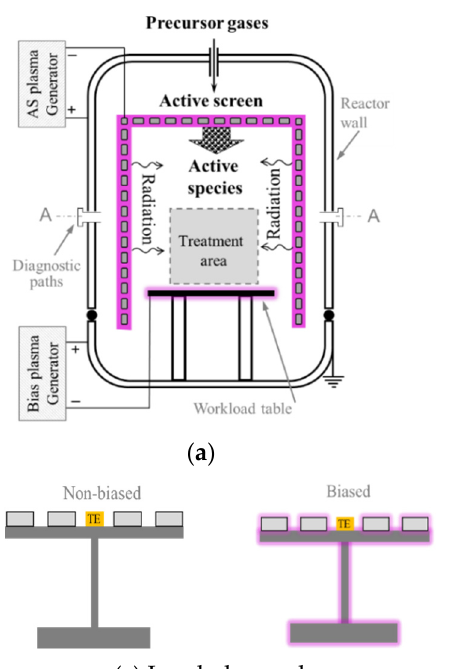
Figure 2. An example of the overview optical emission spectrum recorded by the low-resolution spectrometer with a steel AS at H 2 :N 2 = 1:1, p = 3 mbar, T = 460 °C, Φ Total = 80 slh, Φ CH4 = 4 slh, P AS = 5.8 kW, and P Bias = 0.6 kW ( a ). Selected regions are zoomed in ( b – e ), with the arrows indicating the respective evaluations of peak intensities for N 2+ ( b ), H α ( c ), CN ( d ), and N ( e ). The surface topography of the treated samples was probed with a MIRA3 TESCAN scanning electron microscope (SEM) (TESCAN Orsay holding a.s., Brno, Czech Rpublic).